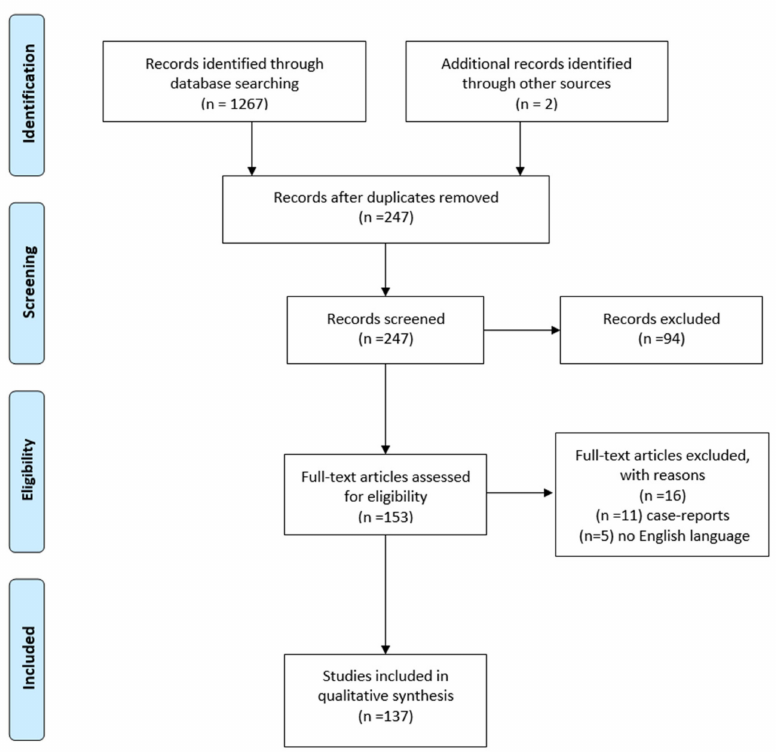
Figure 2. Preferred Reported Items for Systematic Review and Meta-Analysis (PRISMA) 2009 flow